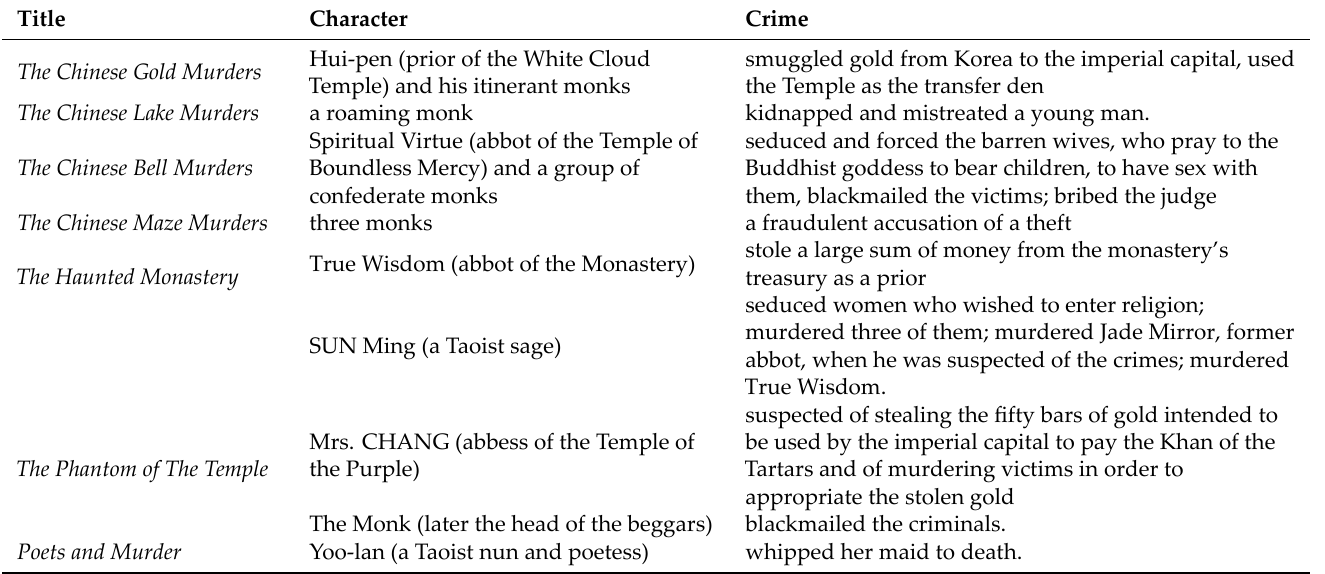
Table 1. Crimes by Clergy in the Judge Dee